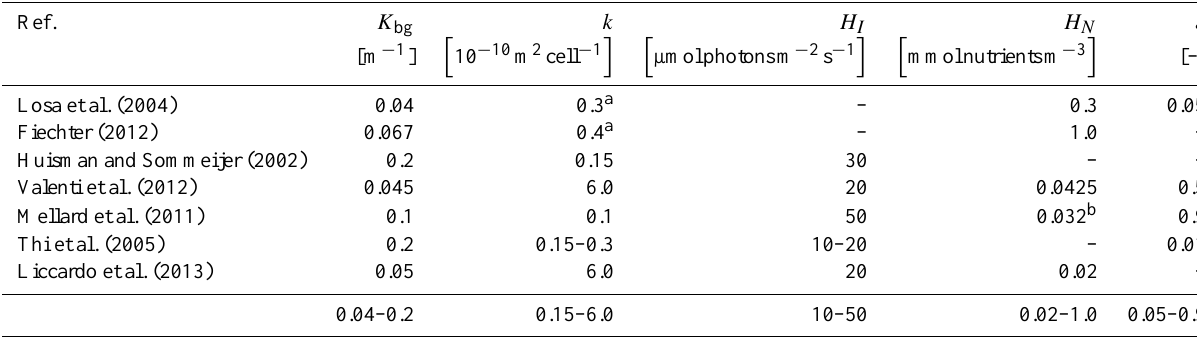
Table 2. Value ranges used in other models.